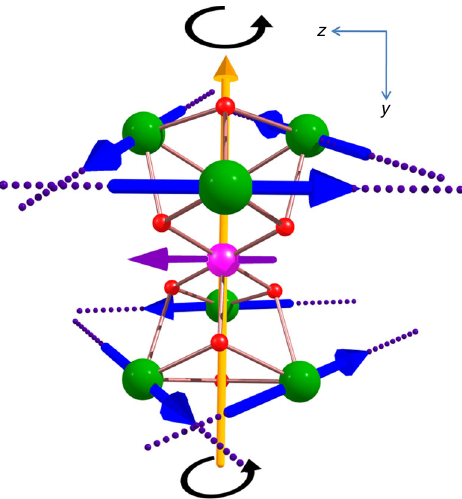
Fig. 5 Orientation of the magnetic anisotropy axes. The directions of the local anisotropy axes in the ground Kramers doublet on each Dy site (dotted lines) in 1 . Blue arrows are the local magnetic moment in the ground exchange doublet. Black arrows show the con rotation of the toroidal magnetic moment and the yellow arrow is the S 6 symmetry axis